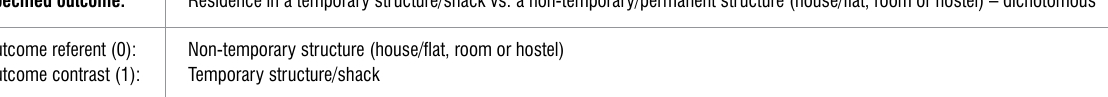
The socio-demographic and economic determinants of residence in a temporary structure/shack vs. a non-temporary or permanent structure (i.e. a house/flat, room or hostel) and the relationship between residence in a (non-)temporary structure/shack and a number of: household-level characteristics (including co-occupancy and household assets, services and amenities) and COVID-19 related phenomena (ease of lockdown compliance, illness and job/business income loss) – both before (Column 2.1) and after (Column 2.2) adjustment for any preceding potential/ candidate confounders. All results are presented as odds ratios (ORs) with 95% confidence intervals in parentheses (95% CI).